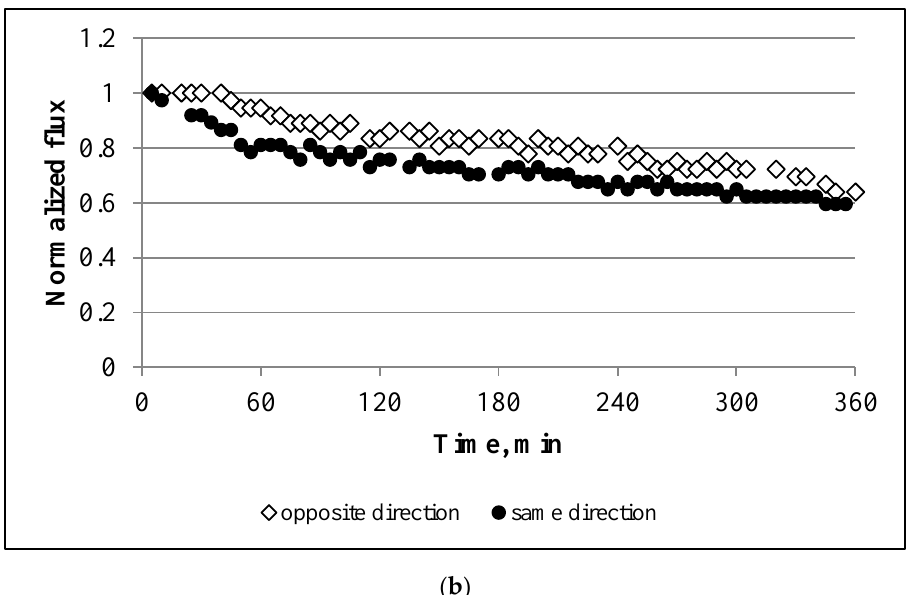
Figure 6. Effect of the: ( a ) cross-flow velocity; and ( b ) feed/draw solution pumping direction on the normalized flux. Experimental conditions: concentrations of NaCl, CaCl 2 , and Na 2 SO 4 are 1.754, 6.132, and 4.487 g/L, respectively; SI = 2.45; and an AL-FS orientation.